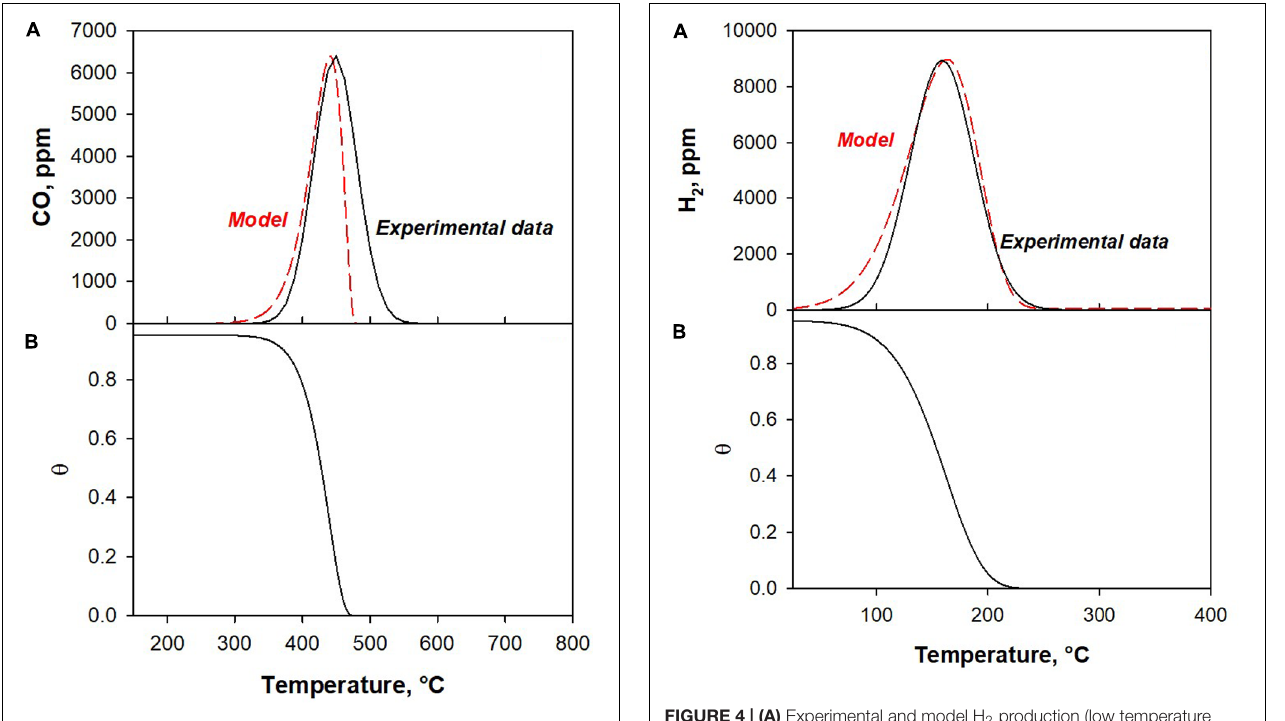
FIGURE 3 | (A) Experimental and model CO production (low temperature peak, bare CO 2 splitting) and (B) the corresponding surface site evolution calculated by the kinetic model.